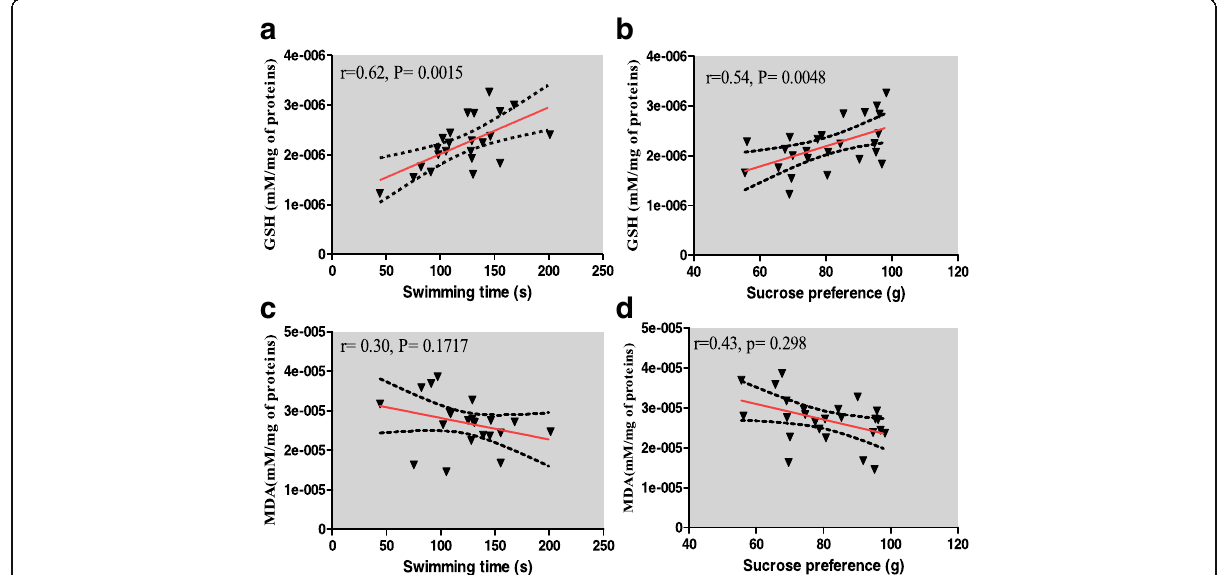
Fig. 13 Pearson correlation between swimming time vs. GSH ( a ), Sucrose preference vs. GSH ( b ), swimming time vs. MAD ( c ) and Sucrose preference vs. MAD ( d ); with the 95% confidence band of the best-fit